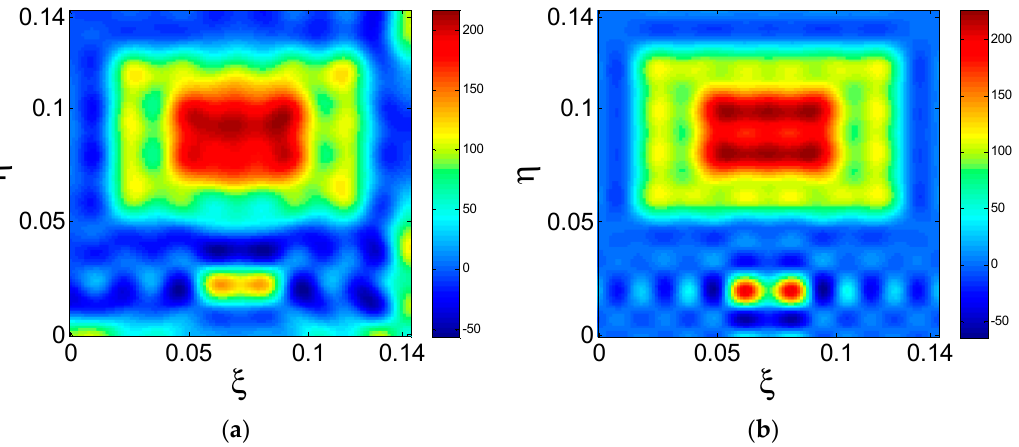
Figure 11. Simulation results. ( a ) The rectangular array. ( b ) The L-shaped array. Table 6. Parameter comparison of the arrays. The reconstructed BT image of the 2-D DPA is much better than that of the 2-D MRA. The two-point sources are distinguished in Figure 11b, but not in Figure 11a. With the same number of antennas, the maximum baselines corresponding to the 2-D DPA are 15 along two dimensions, and the maximum baselines corresponding to the 2-D MRA are 12 and 13 along two dimensions. The ranks are 250 and 145, respectively. Therefore, the 2-D DPA with an almost full-rank transformation matrix has a larger maximum baseline than the 2-D MRA with a rank-defificient transformation matrix, providing higher image quality and spatial